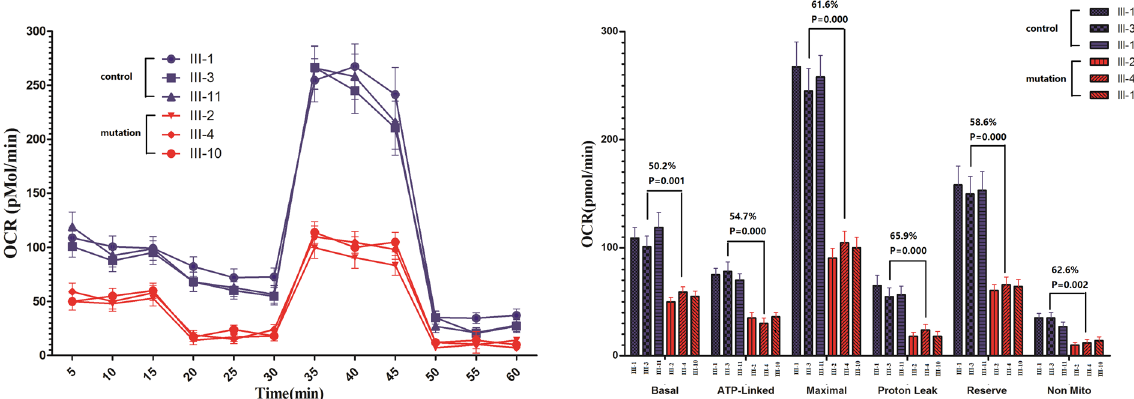
Figure 5. The tRNA Met C4467A mutation contributes to a decrease of mitochondrial oxygen consumption. The basal OCR, ATP-linked OCR, proton leak OCR, maximal OCR, reserve capacity and non-mitochondrial decreases were 50.2%, 54.7, 61.6, 65.9, 58.6 and 62.6% compared with the control cell lines (P < 0.05), respectively.